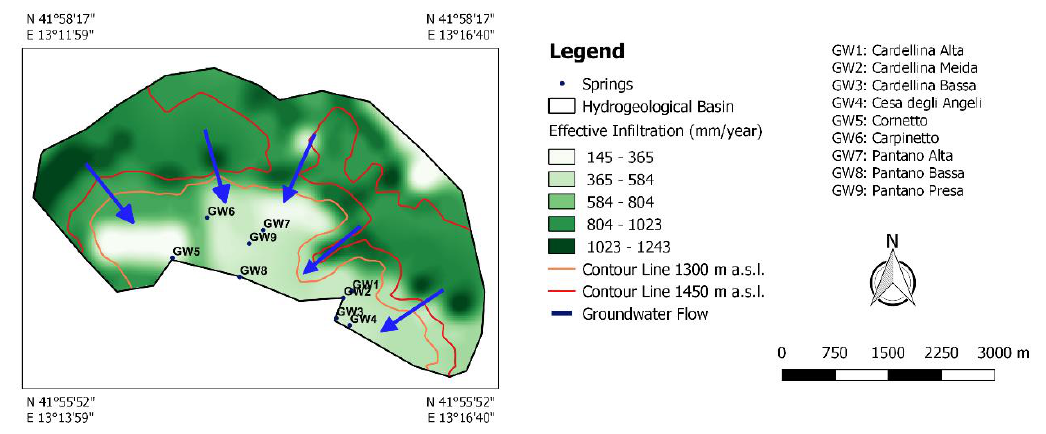
Figure 8. Hydrogeological basin recharge areas and groundwater flowpaths.